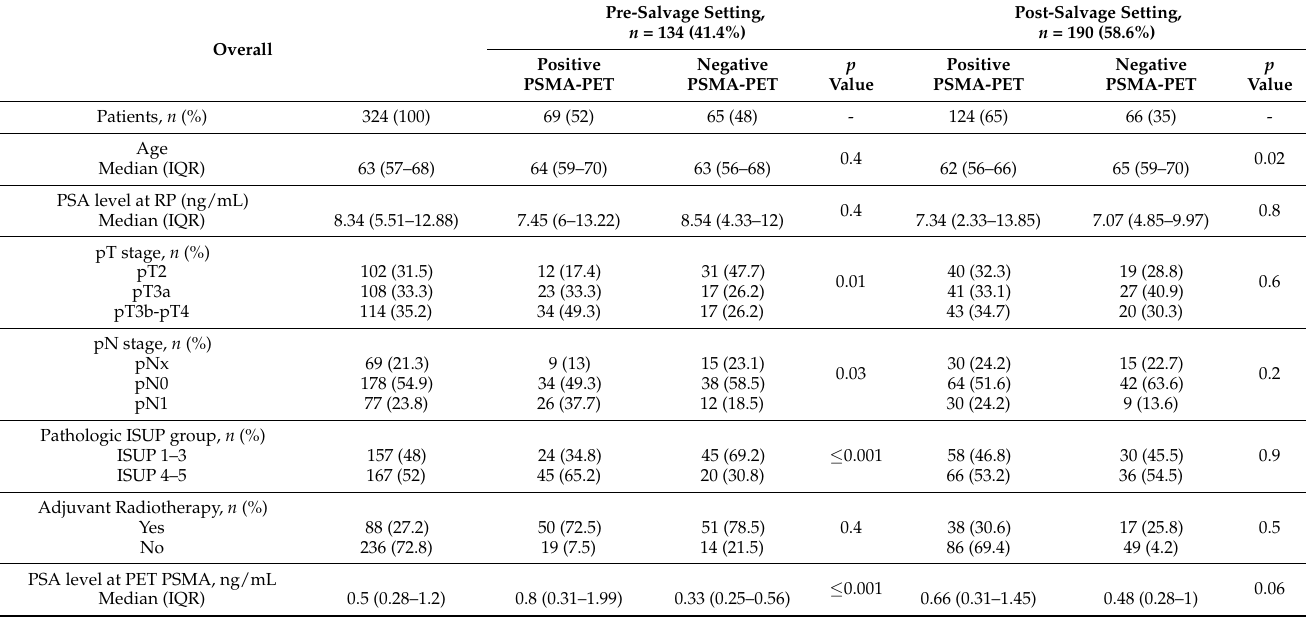
Table 1. Descriptive characteristics in the overall population ( n = 324), in the pre-salvage ( n = 134) and post-salvage ( n = 190) setting stratifying according to PSMA-PET results (namely, positive vs.